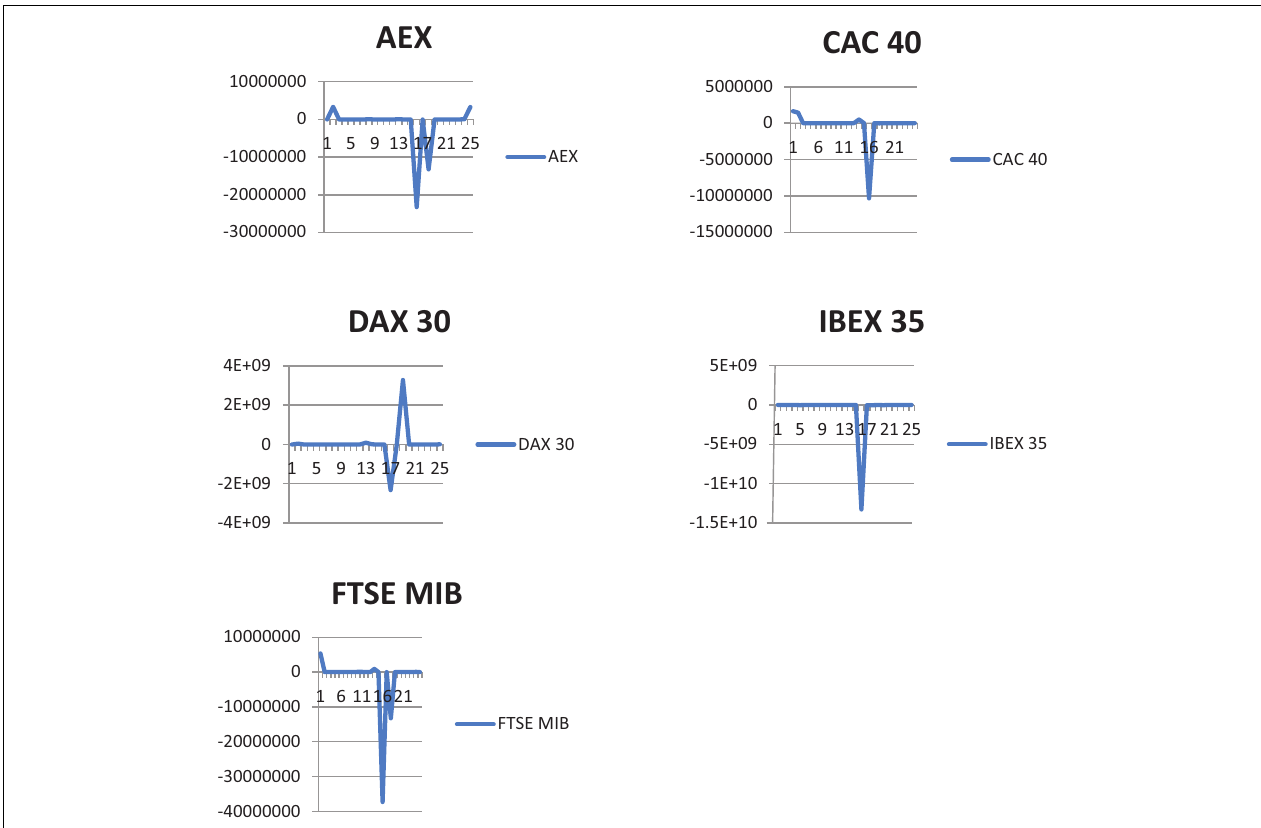
FIGURE 2 | Optimized algorithmic trading system P&L for AEX, CAC 40, DAX 30, IBEX, and FTSE MIB.